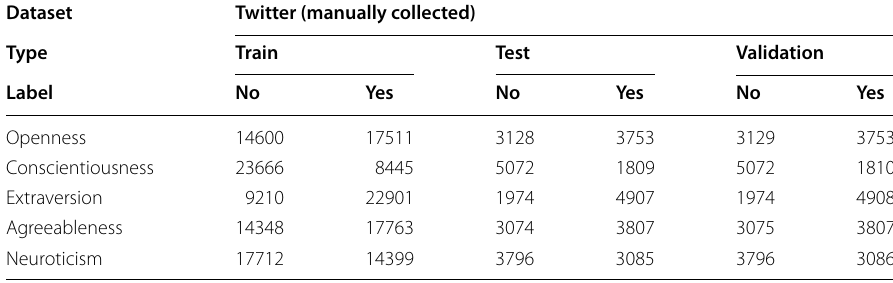
Table 3 Twitter dataset